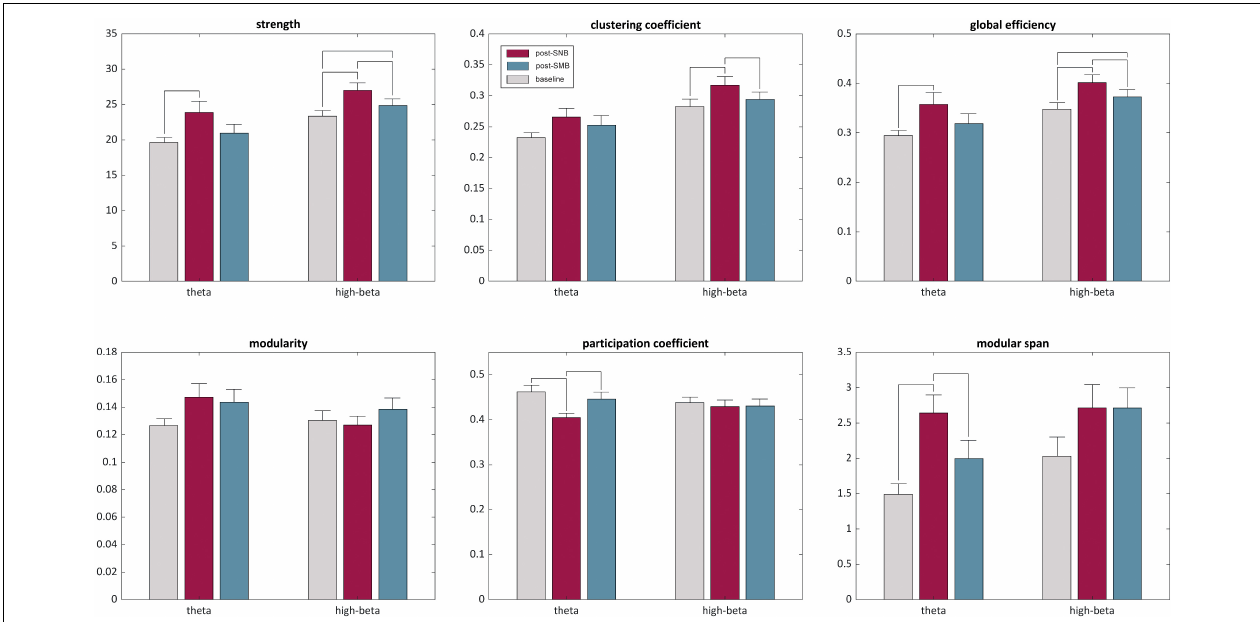
FIGURE 5 | Graph theoretic metrics for theta and high-beta networks. Descriptive statistics of theta and high-beta bands are presented for the three phases (baseline, post-SNB, and post-SMB) as mean + standard error for the estimated graph metrics. For each metric and band, significant post hoc (i.e., between phases comparisons) are highlighted by horizontal lines, connecting the corresponding